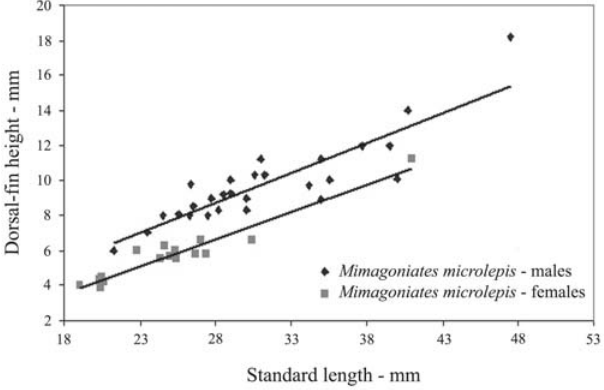
Fig. 88. Mimagoniates microlepis . Dorsal-fin height as function of SL by